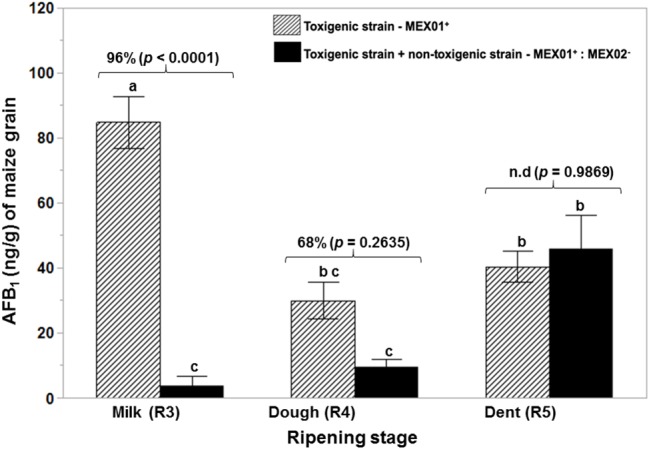
Effect of a non-toxigenic strain (AFL-MEX02) of A. flavus when co-inoculated with a wild type toxigenic strain (AFL + MEX01) on aflatoxin B1 production when applied as a mixed inoculum (50:50) to maize cobs of different ripening ages (R3, R4, R5) after 10 days at 30°C. The percentage values above the bars show relative reduction of AFB1, and the values of p (<0.05) indicate evidence of difference from the control (toxigenic strain). Treatments with the same letters show no differences in the ripening stages using the Tukey’s HSD test at 5% significance. n.d. – AFB1 reduction not detected.